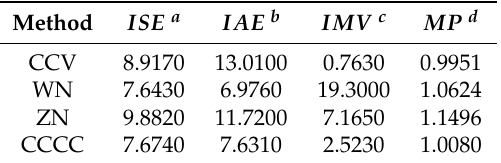
Table A9. Performance indexes. Set-point tracking for the set P 5 .